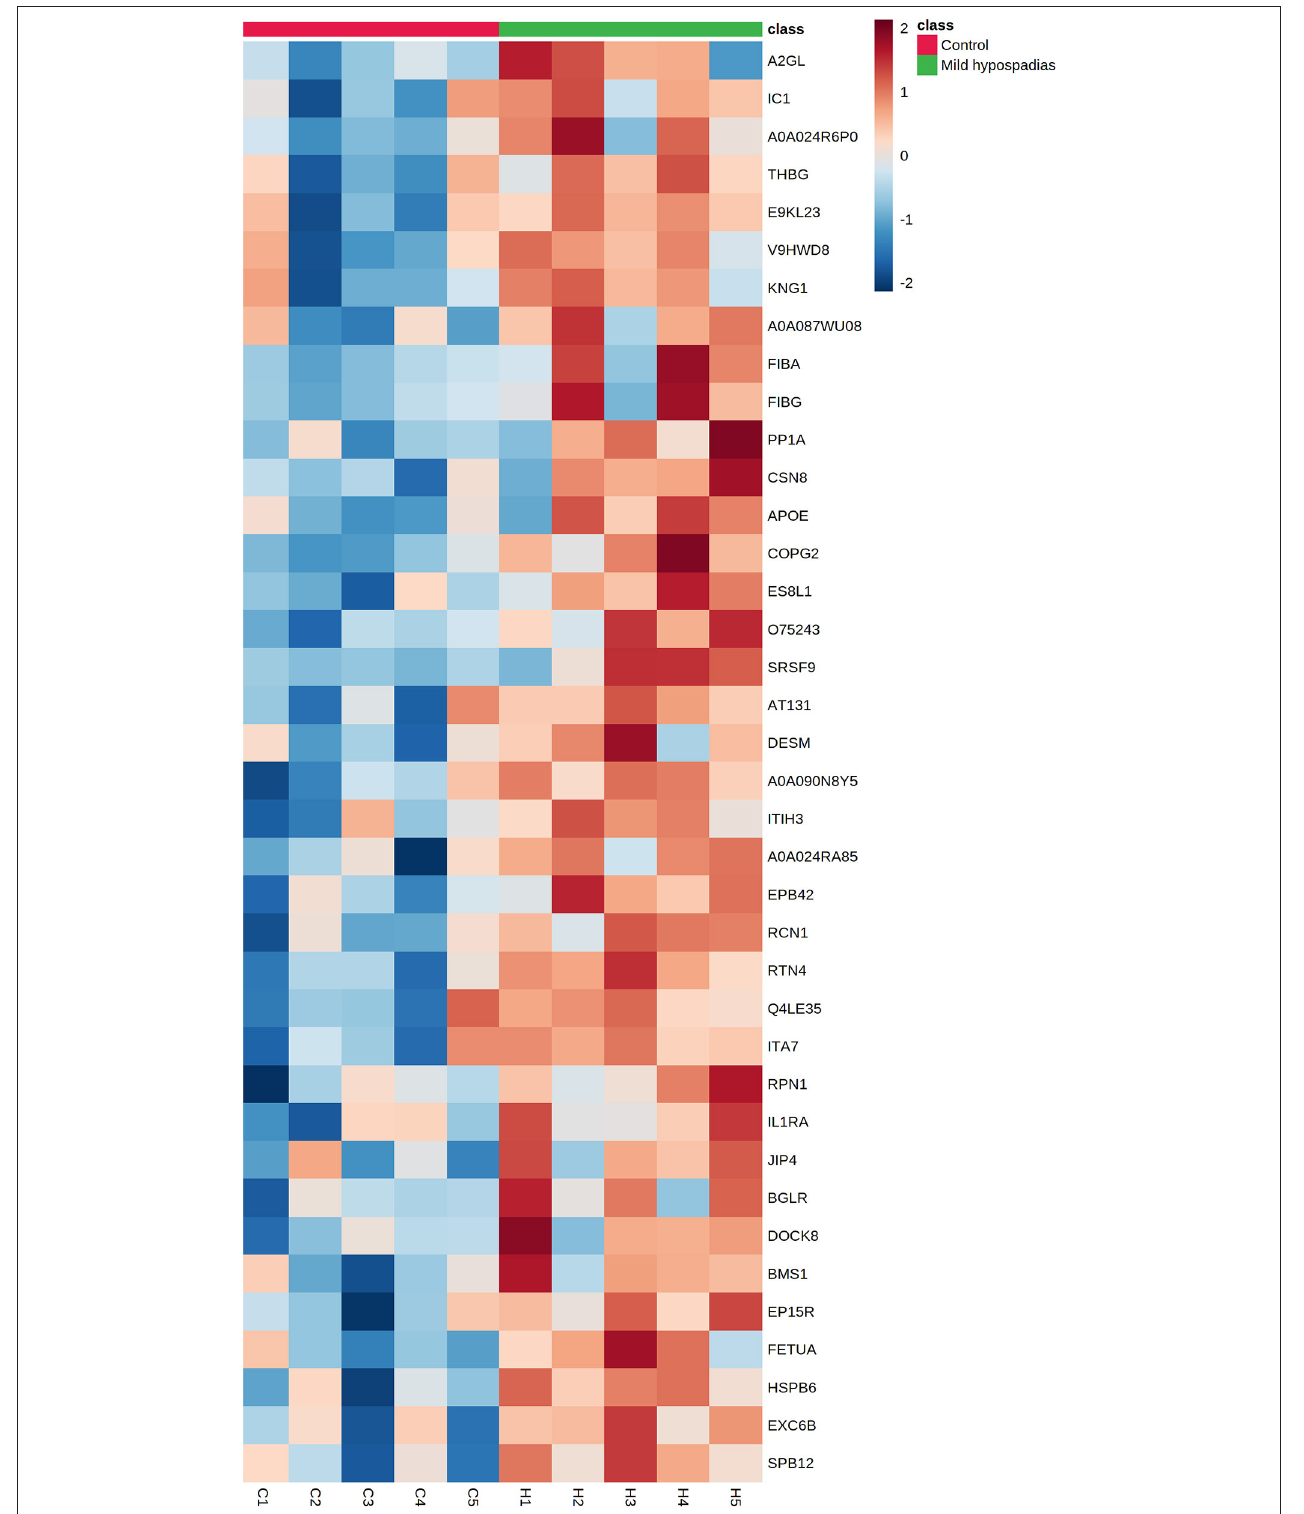
FIGURE 4 | Proteins found upregulated in the proteome from mild hypospadias patients. Thirty-eight proteins were found increased between control and mild hypospadias samples. Heatmaps depict protein abundance changes in terms of Zq across samples (C1-C5 for control and H1-H5 for mild hypospadias samples). The magnitude of abundance change [increased (red) or decreased (blue)] is shown according to the color scale on the right.